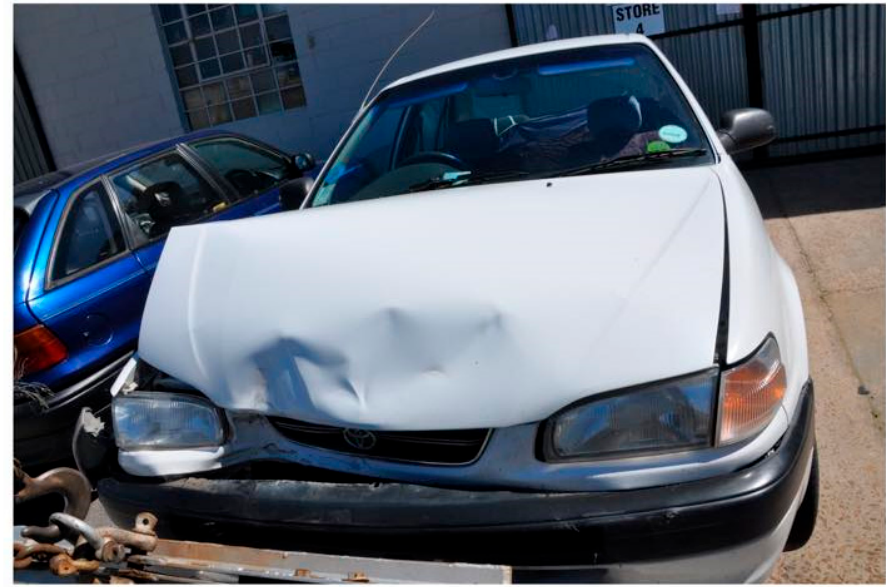
Figure 1. A photo of a motor vehicle crash submitted by a junior doctor as part of the ‘ Share your Story ’ campaign. The intern doctor worked a 26-h extended shift and was required to drive to a clinic to work an additional 5 h, when they were involved in a collision. Reproduced with permission from the photographer.